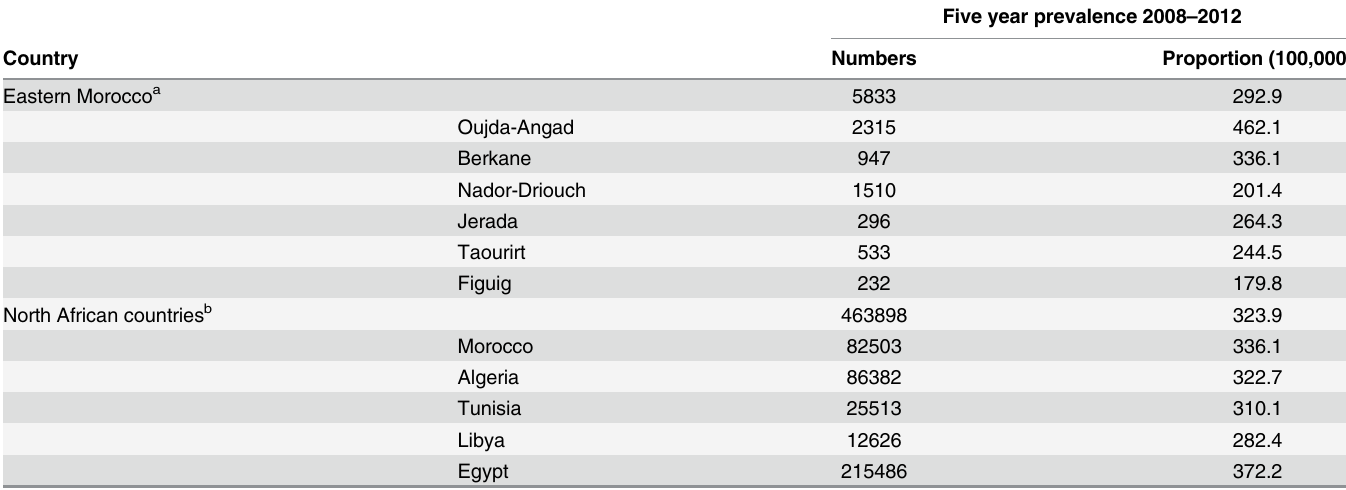
Table 3. Five-year prevalence proportions for all cancers in area of Eastern Morocco as compared to other North African countries.